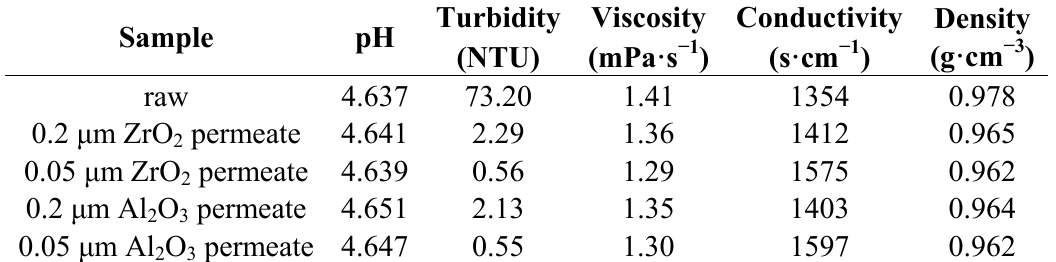
Table 4. The physical and chemical parameters of samples filtered by four